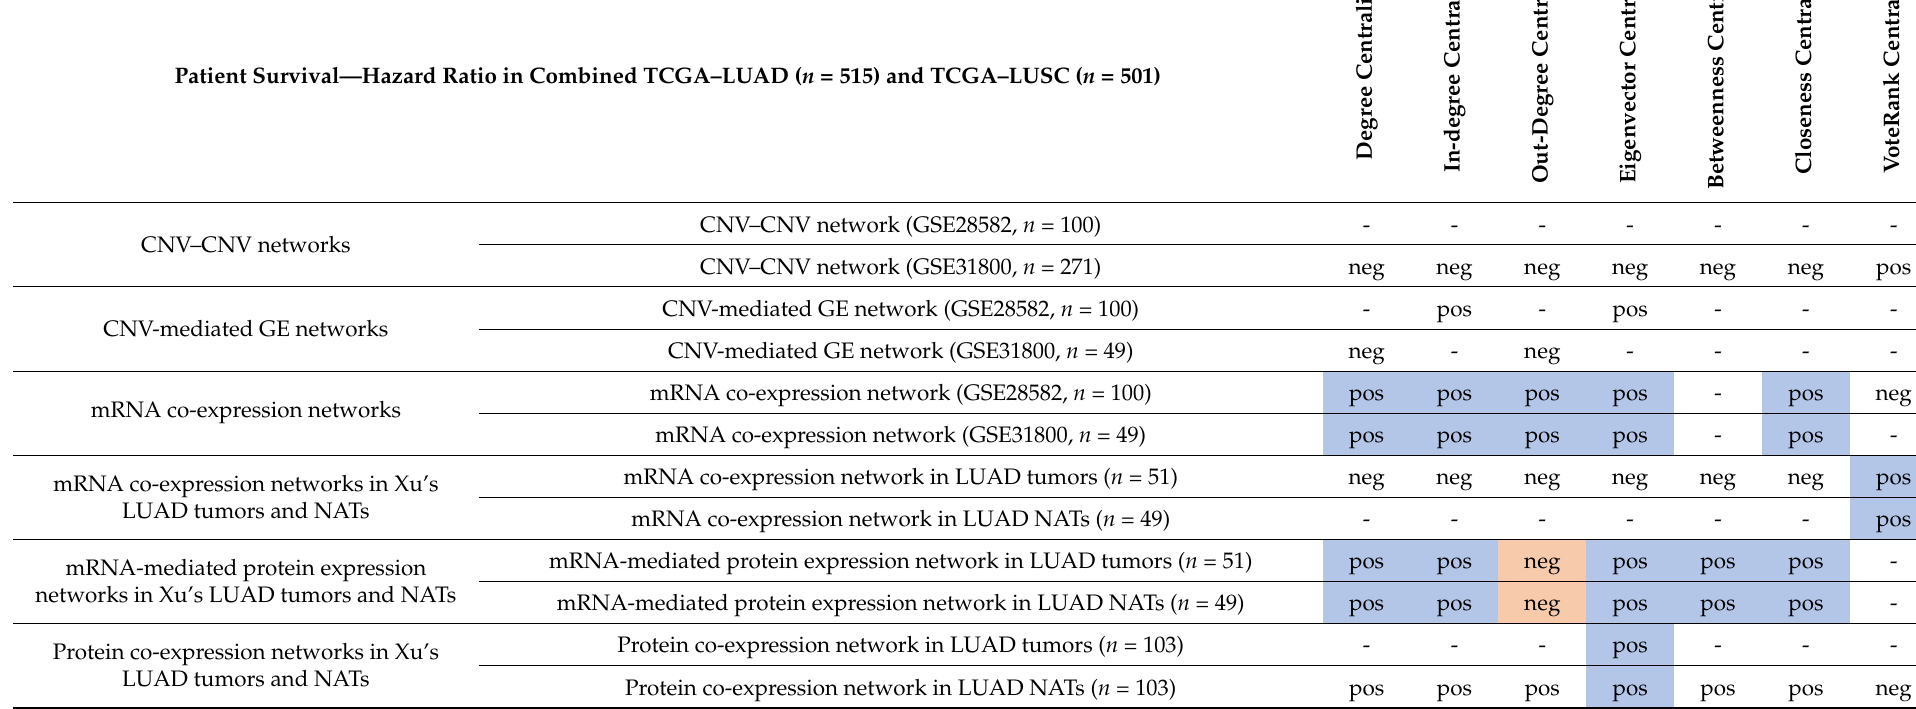
Table 6. Correlations of seven centrality metrics of selected networks with hazard ratios in univariate Cox modeling of combined TCGA–LUAD ( n = 515) and TCGA–LUSC ( n = 501). pos: Pearson’s correlation coefficient r > 0 and p < 0.05; neg: r < 0 and p < 0.05. The blue color indicates concordant positive correlations. The orange color indicates concordant negative